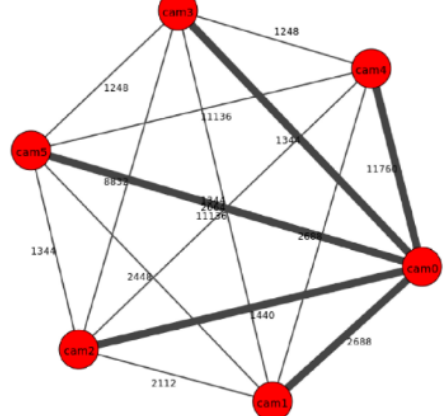
Figure 7: Graph of observations used in calculating the relative camera poses. Nodes – cameras (IDs follow the ordering in the tables), weights – number of common tie points for each sensor pair